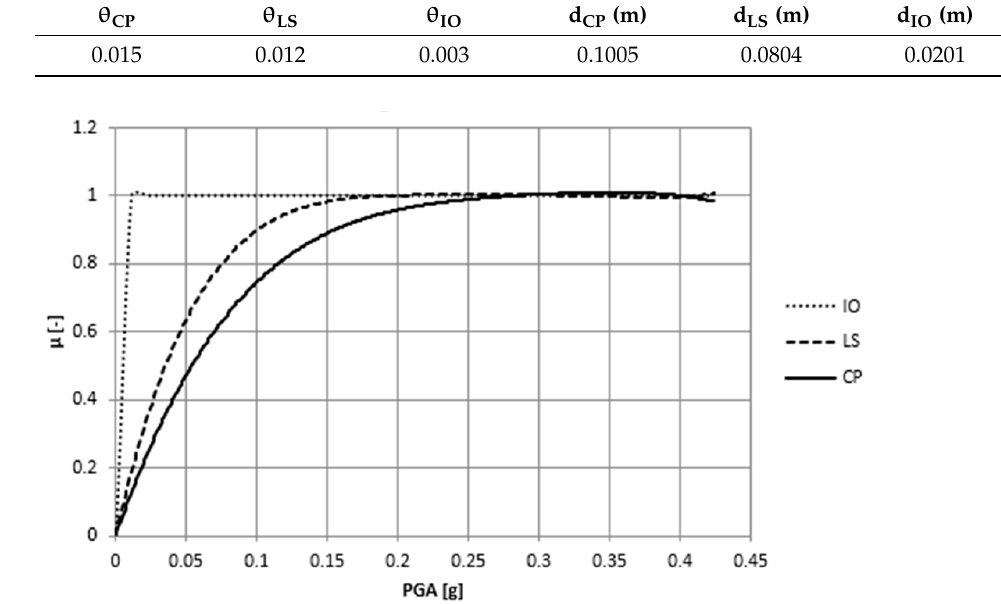
Figure 18. Fragility curves of the intermediate frame in the X -direction with hinged connections.